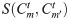
(left) S(Cmt,Cm′t) of 16 TCs in 1991, computed using forward intimacy indices going from 1991 to 1992. (right) T(Cmt,Cm′t) of the same 16 TCs, using information from 1991 only. We use the same ordering of TCs in both matrices.